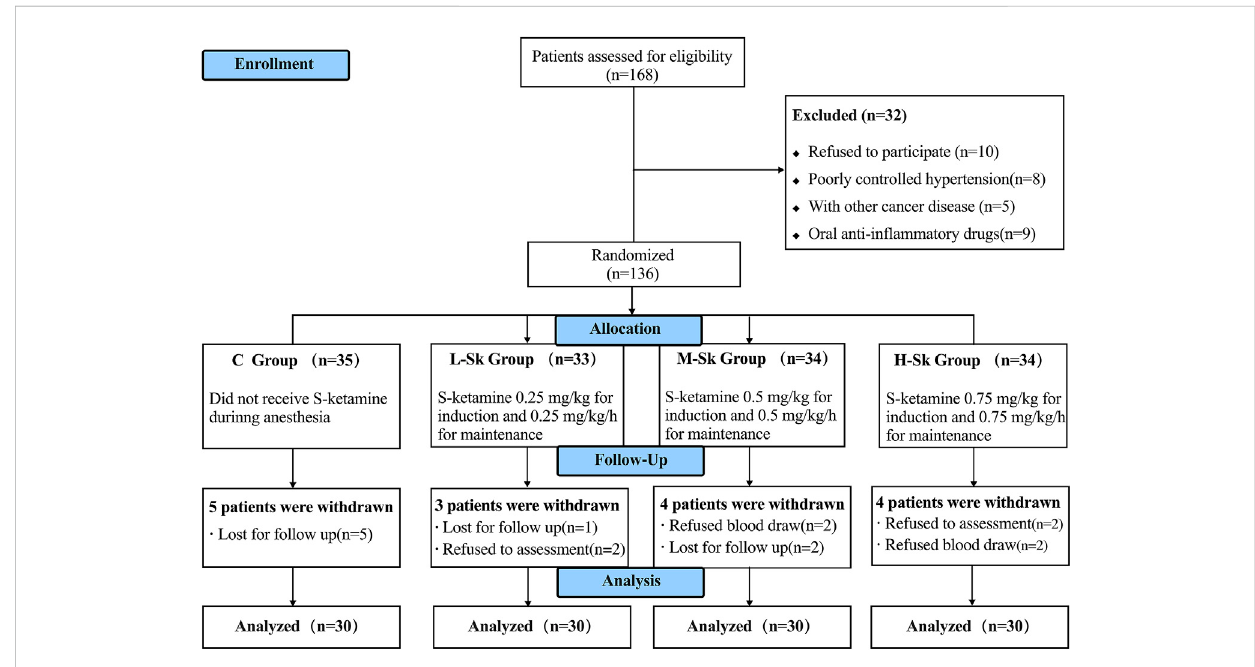
FIGURE 1 Flowchart of Consolidated Standards of Reporting Trials (CONSORT) describing patients ’ progress throughout the study.